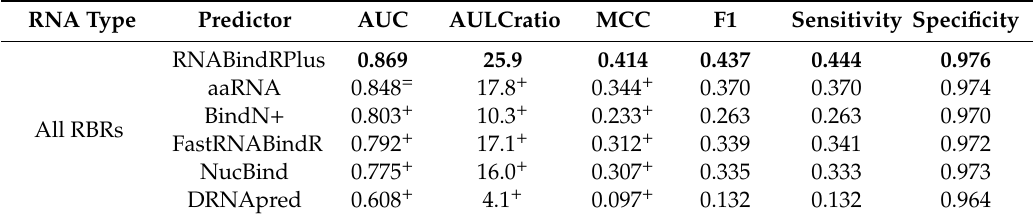
Table 3. Predictive performance of the six partner-agnostic sequence-based predictors of RBRs on the benchmark